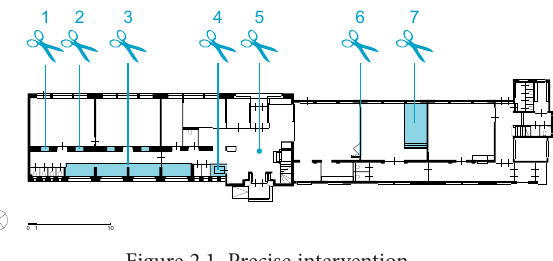
Figure 2.1. Precise intervention